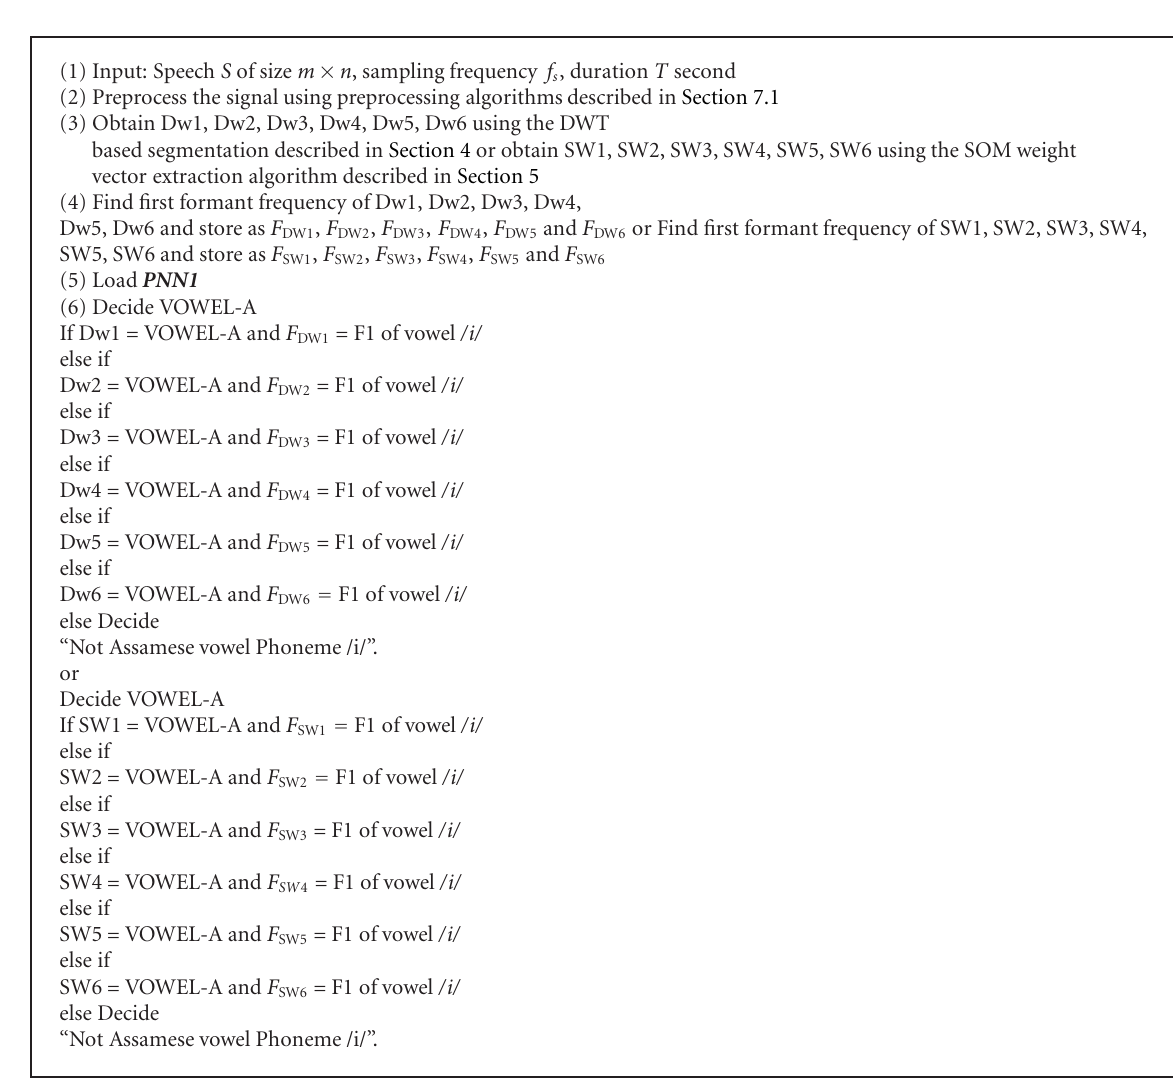
Algorithm 3: PNN and F1 based recognition algorithm.